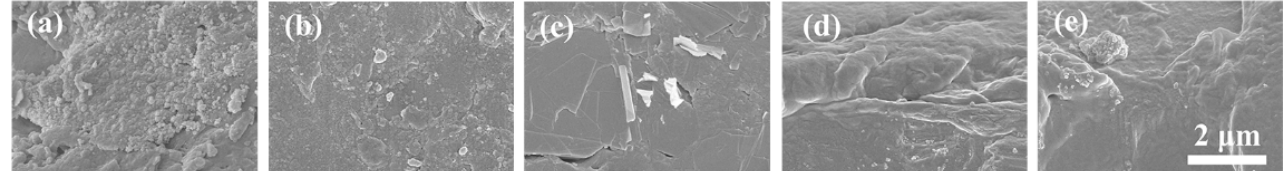
Figure 4. Cross-sections of unmodified and modified samples: ( a ) 80Zn; ( b ) 2CB-67Zn; ( c ) 2CG-67Zn; ( d ) 2MWCNT-67Zn; ( e ) 2PANI-67Zn.